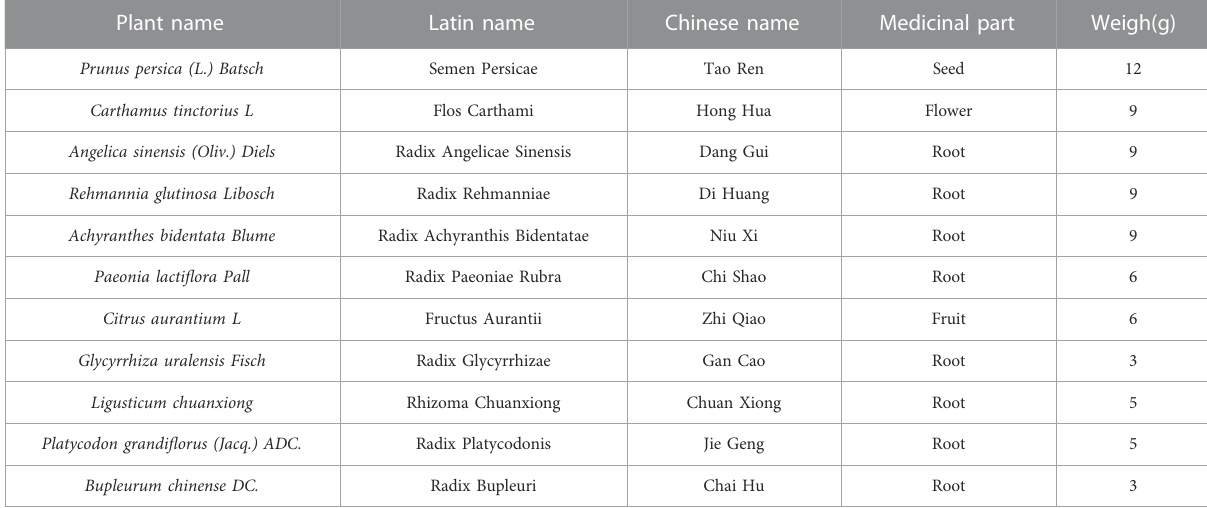
TABLE 1 Compositions of Xuefu Zhuyu